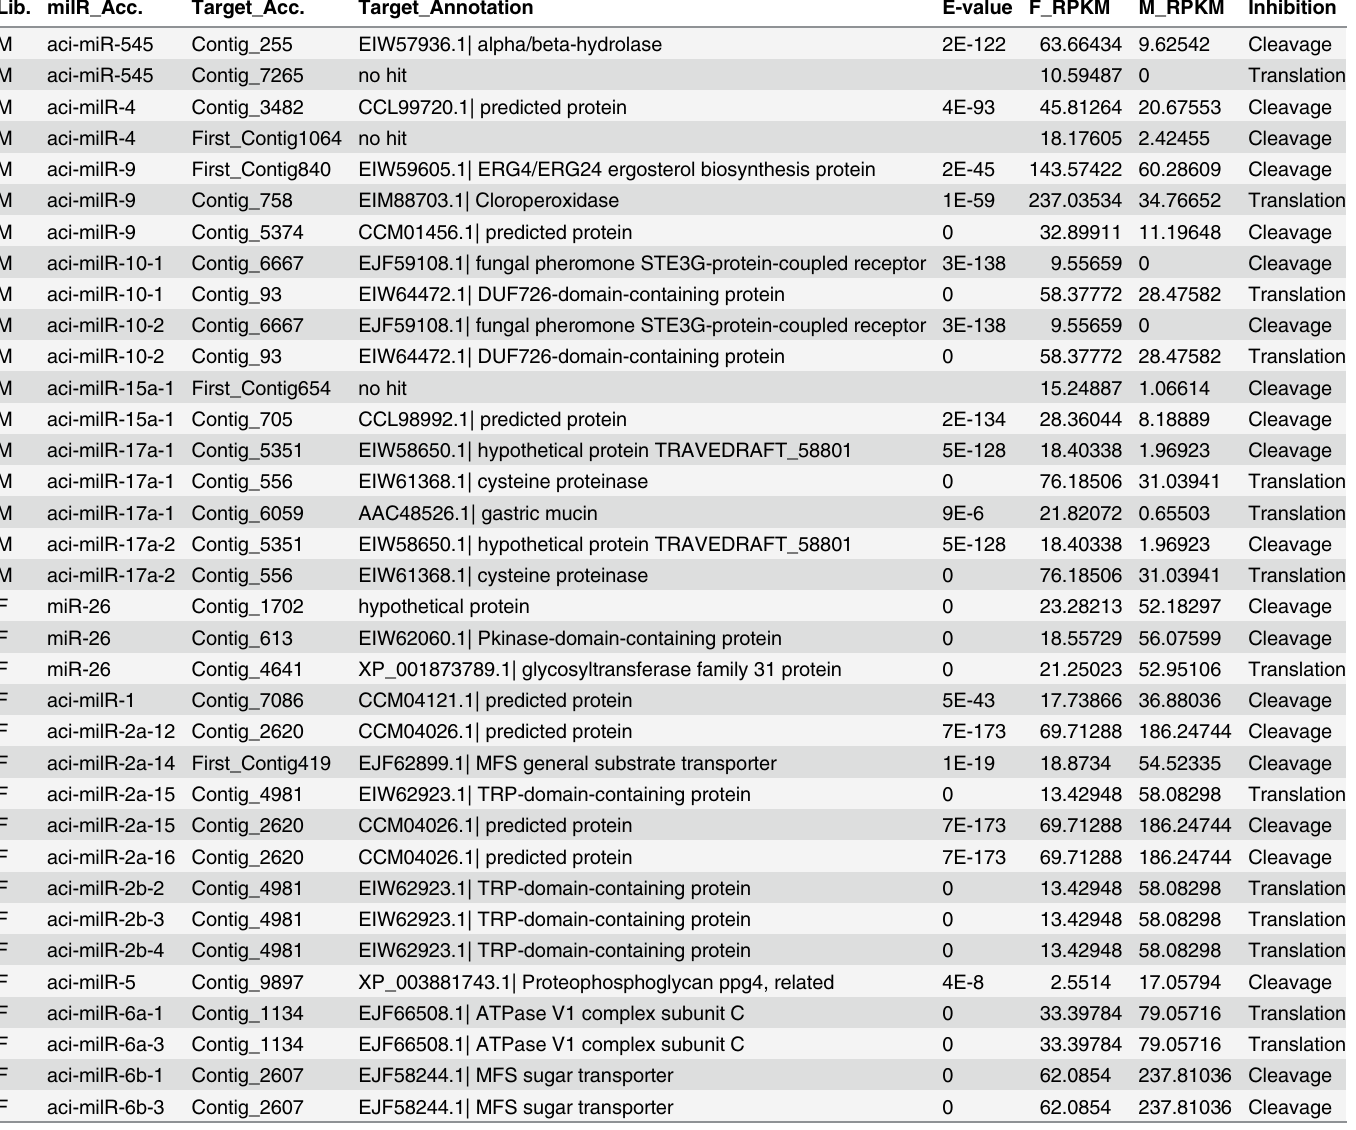
Table 5. Target prediction of conserved miRNA and novel predicted milRNA candidates. Lib.